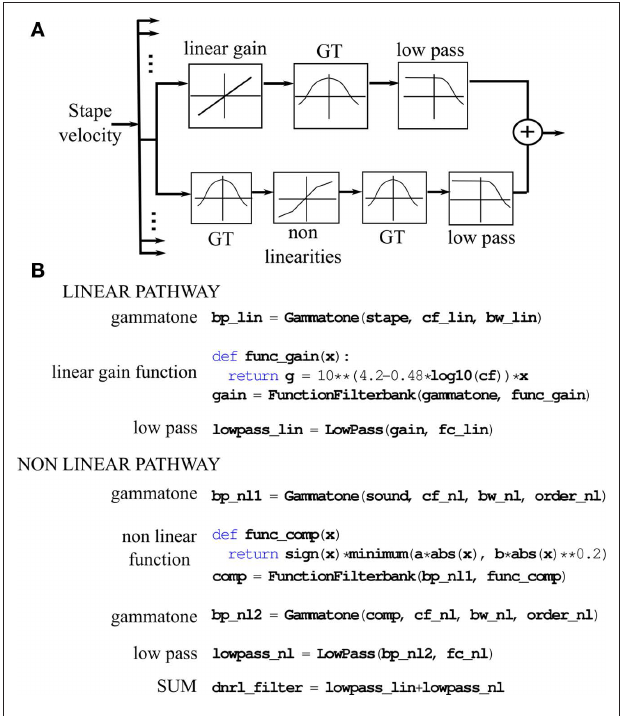
FiGUre 3 | Dual resonance non-linear model of basilar membrane filtering. (A) Box representation of one frequency channel of the DRNL cochlear model. (B) Python implementation of the full model using the Brian